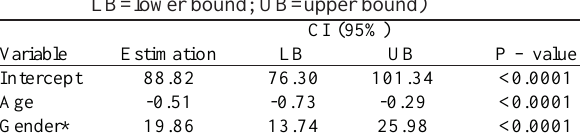
Table 3. Estimated MIP linear regression model containing only the covariates of age and gender. (CI=confidence